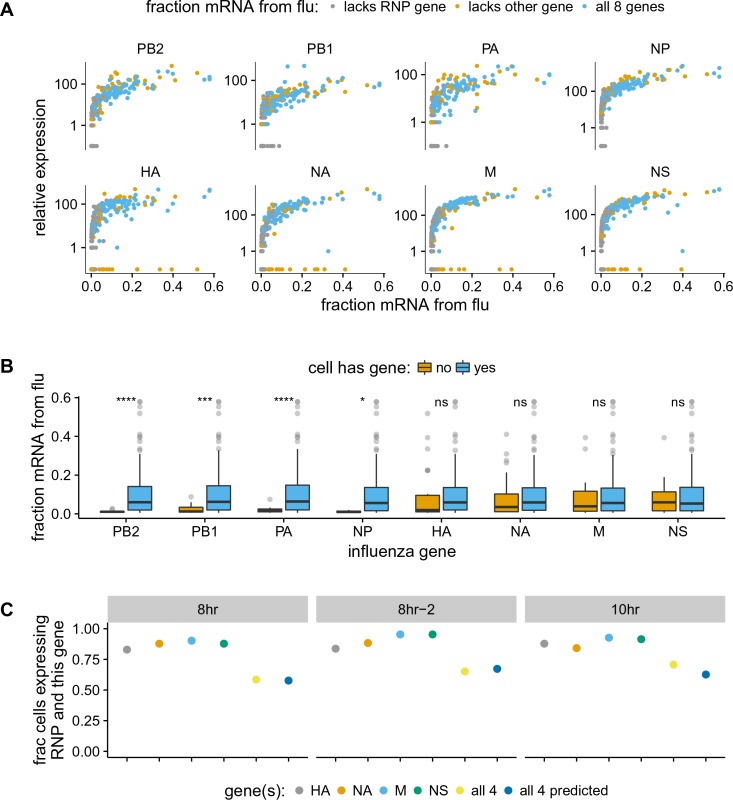
The absence of viral genes explains some of the variability in the amount of viral mRNA per cell.(A) The normalized expression of each viral gene as a function of the total fraction of mRNA in each infected cell derived from virus, taken over all time points. Cells with high viral burden always express all RNP genes, but some cells with high viral burden lack each of the other genes. Plots for individual samples are in Figure 5—figure supplement 2, and a plot that excludes known coinfected cells is in Figure 5—figure supplement 3 . (B) Box and whisker plots showing the per-cell viral burden among cells with >0.5% of their mRNA from virus, binned by whether or not the cells express each gene. A Wilcoxon signed-rank test was used to test the null hypothesis that absence of each gene does not affect viral burden: **** = P<10-4, *** = P<10-3, * = P<0.05, ns = not significant. The trends are similar if we look only at the 10 hr sample Figure 5—figure supplement 4 or exclude known co-infected cells ([fluburdenbyflugene]fluburdenbyflugene_nocoinfection).Figure 5—figure supplement 5 . (C) The fraction of cells that express each of the four other genes among cells that express all RNP genes, as well as the fraction that express all four of the other genes. The fraction that express all four genes is well predicted by simply multiplying the frequencies of cells that express each gene individually, indicating that gene absence is approximately independent across these genes.10.7554/eLife.32303.021Figure 5—source data 1.The numerical data for panel (C) are in p_missing_genes.csv.10.7554/eLife.32303.022Figure 5—source data 2.Simulation with a simple model for the expected heterogeneity due to Poisson co-infection and presence/absence of the full RNP is in simple_Poisson_model.html.